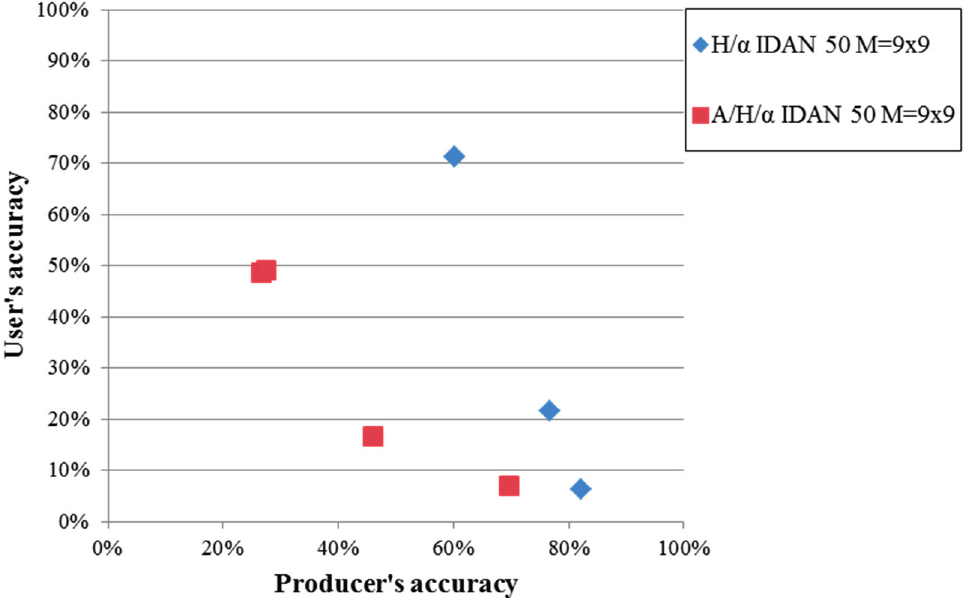
Figure 8. Development of user’s accuracy vs. producer’s accuracy for the OBIA improvements (for the best results of the pixel-based PolSAR classification) based on H/ α or A/H/ α , respectively (for the first TerraSAR-X acquisition (5 September 2010)). Processing steps from lower right to upper left: (1) pixel-based, (2) first s-e, (3) rule-set, (4) second s-e. Please notice that the third and fourth point are located very close to each other (valid for both, H/ α and A/H/ α